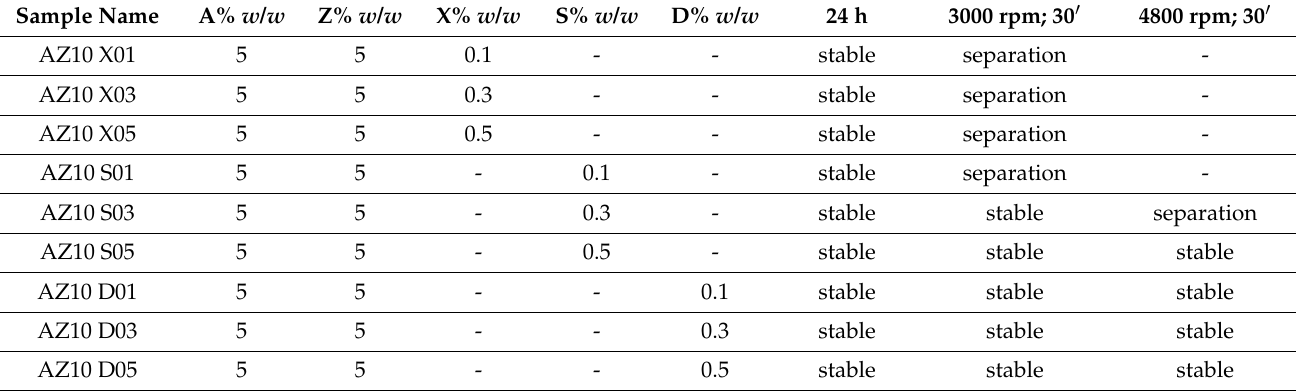
Table 3. Stability test results of systems with 10% w / w of oil phase emulsified with the ternary associations of Zea mays starch (A), zinc oxide (Z), and a polysaccharide at increasing